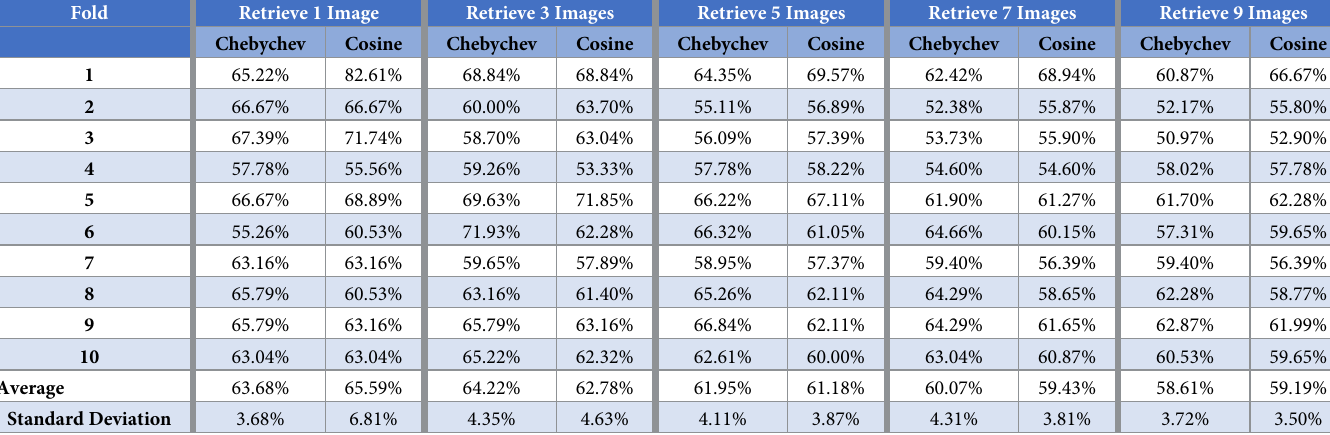
Table 4. Retrieval accuracy of 1, 3, 5, 7, and 9 CBIR image retrievals with traditional KNN classification and handcrafted features for each 10-fold. Fold